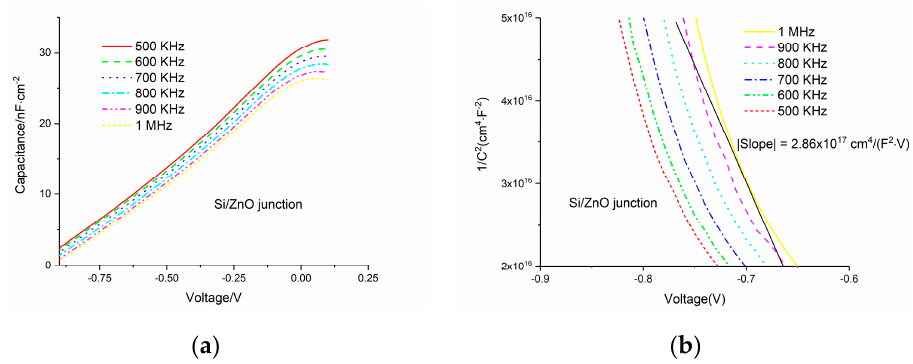
Figure 4. ( a ) Capacitance–voltage measurement data for the p-Si/i-ZnO junction; ( b ) 1/C 2 –V curve for p-Si/i-ZnO junction.